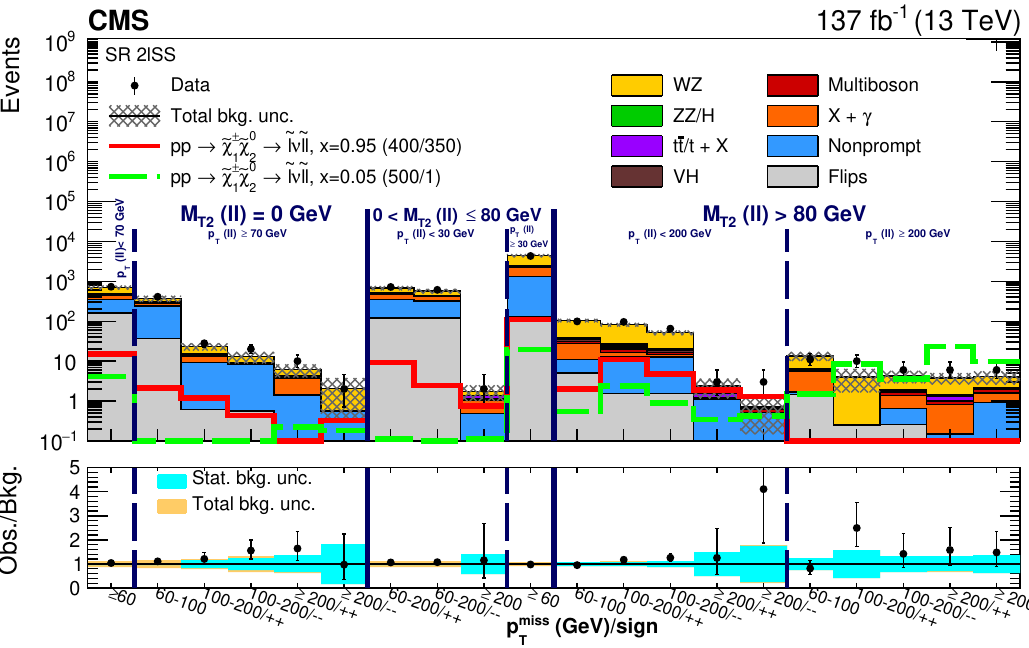
Figure 7 . Observed and expected yields across the search regions in events with two same-sign light leptons (2 ‘ SS). Several signal models are shown superimposed. They correspond to with slepton-mediated decays in the flavor-democratic hypothesis for a compressed δm = 50 GeV (red line) and uncompressed δm = 500 GeV (green dashed line) scenario. The legends specify the 0 0 masses of and for the shown signal distributions as ( m e c e c 2 1